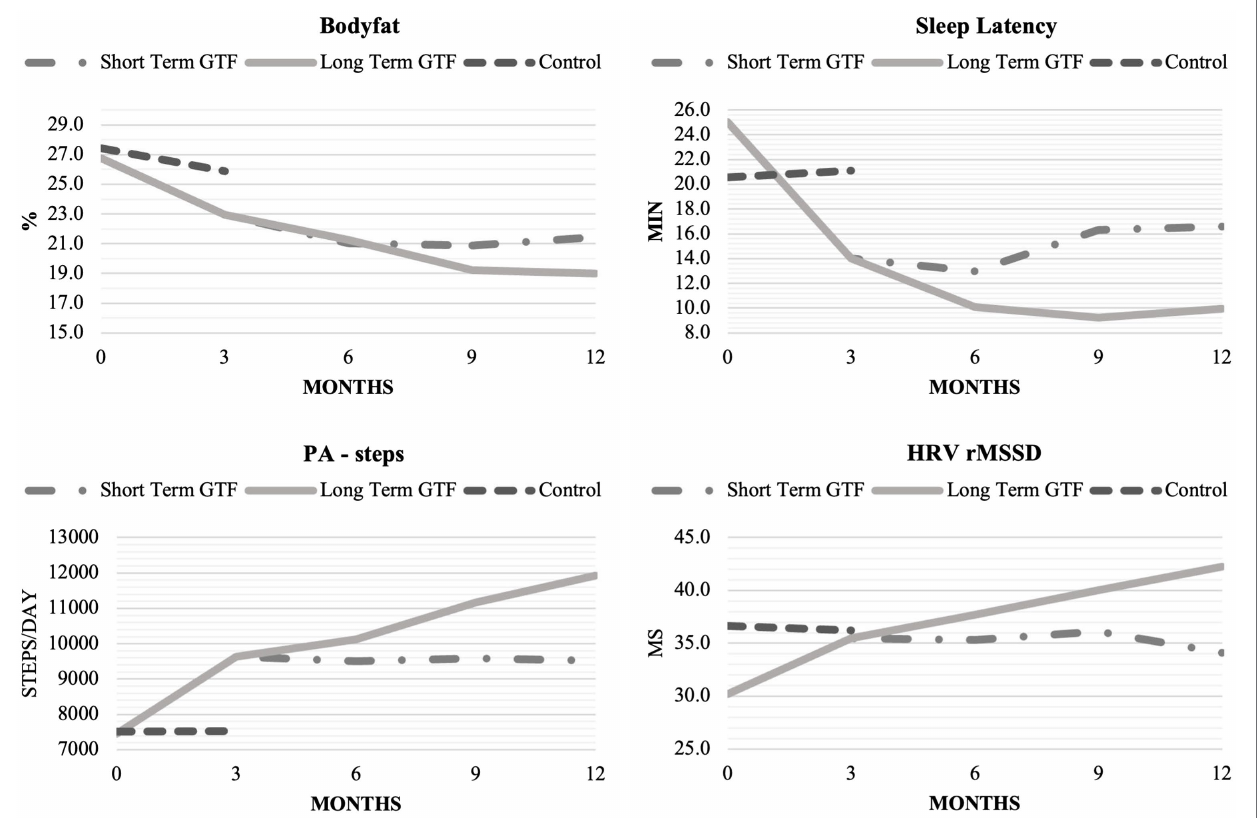
FIGURE 6 | Evolution of Body Fat %, Sleep Onset Latency, Step Count, and rMSSD during the